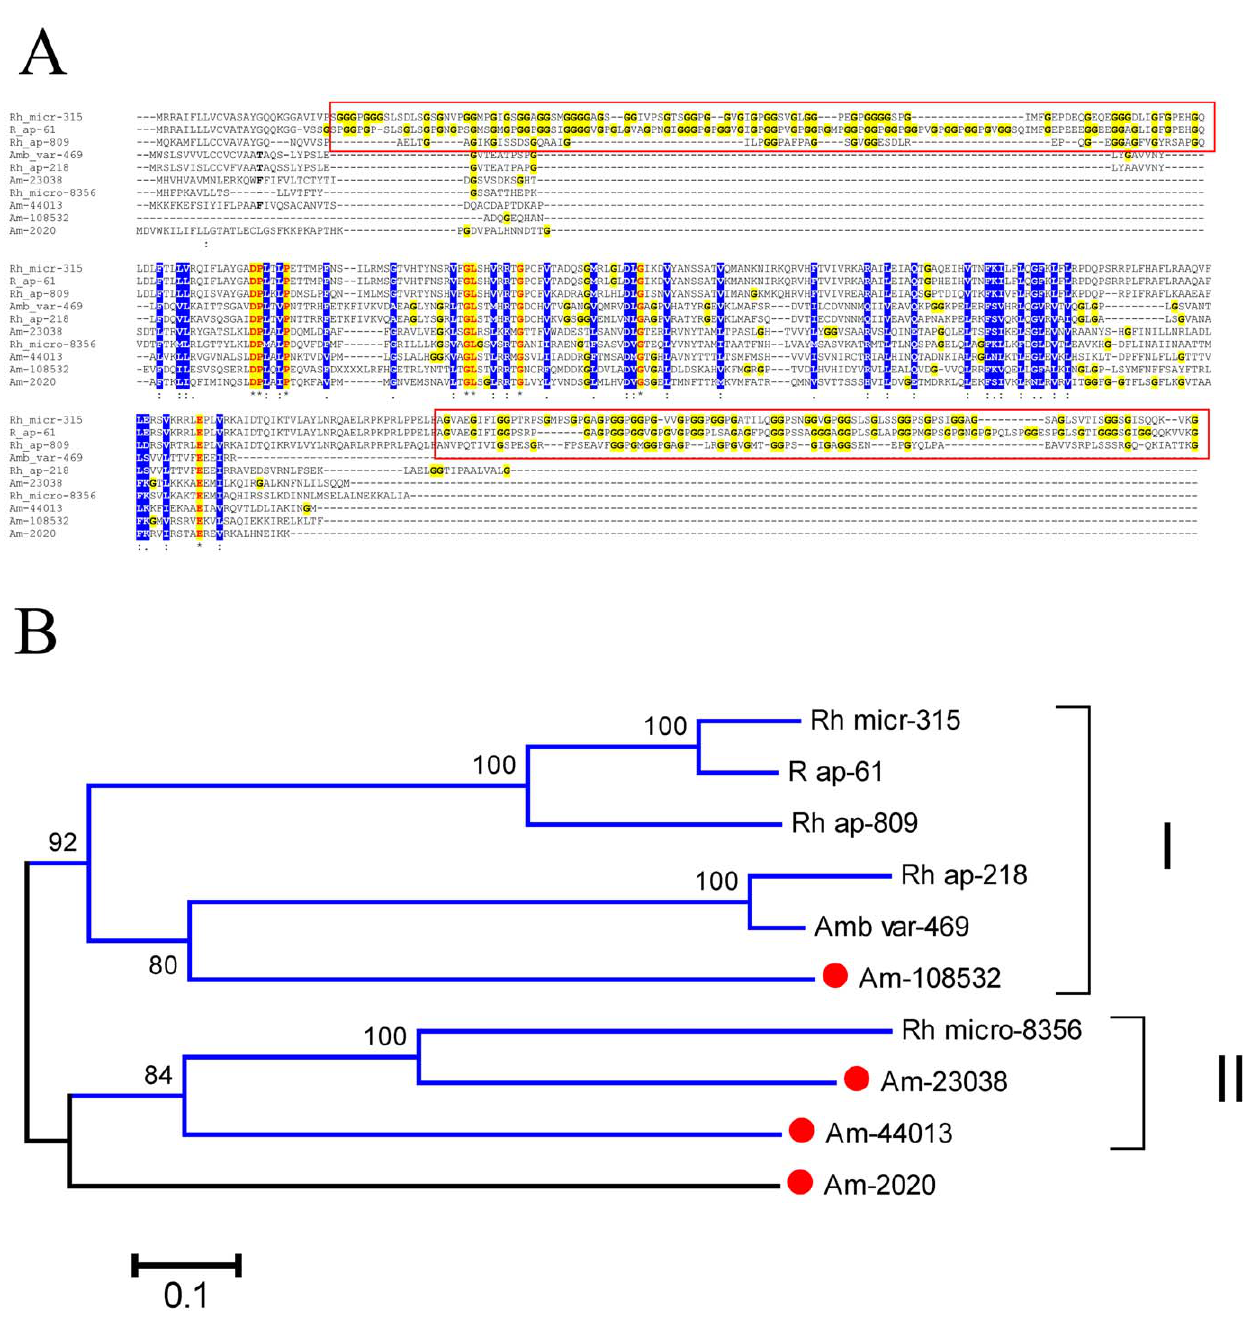
Figure 11. The salivary 40–279 novel family of metastriate ticks. ( A ) Clustal alignment. The symbols at the bottom indicate (*) identity of residues, (:) conserved and (.) less conserved residues. Identical residues are represented with red letters and yellow background. Conserved residues are shown in blue background. Glycines are shown in yellow background. The red boxes mark the glycine rich regions of 3 Rhipicephalus sequences. ( B ) Bootstraped phylogram of the alignment in A. The numbers at the nodes indicate the bootstrap support and the bar at the bottom indicates 10% amino acid divergence. The Amblyomma maculatum protein names start with Am- and are recognized by a red circle marker. Remaining sequences are from Rhipicephalus microplus , R. appendiculatus and A. variegatum . Clades with strong bootstrap support are indicated with Roman numerals.